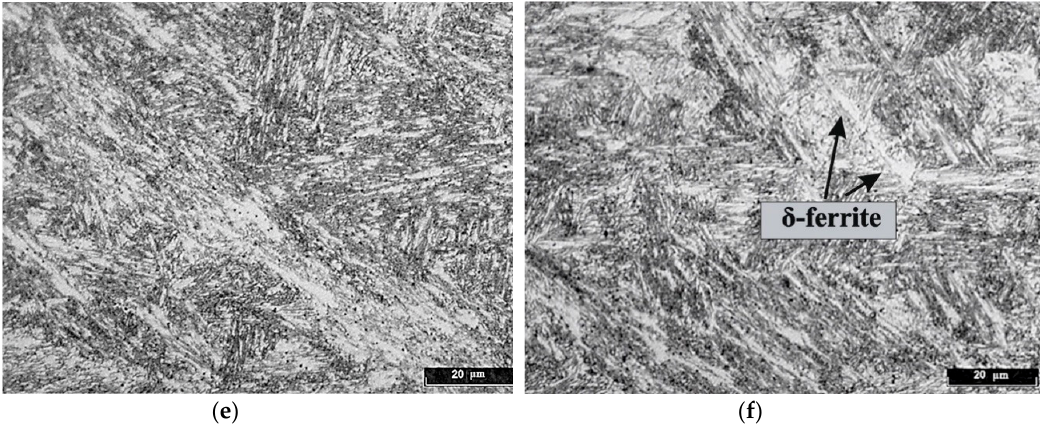
Figure 4. The microstructure of 06Cr15Ni4CuMo ( a ) DLD; ( b ) mode 1 ( Т = 750 ° С , t = 2 h); ( c ) mode 2 ( Т = 650 ° С , t = 2 h); ( d ) mode 3 ( Т = 650 ° С , t = 4 h); (e ) mode 4 ( Т = 620 ° С , t = 2 h); ( f ) mode 5 ( Т = 620 ° С , t = 2 h/x2.